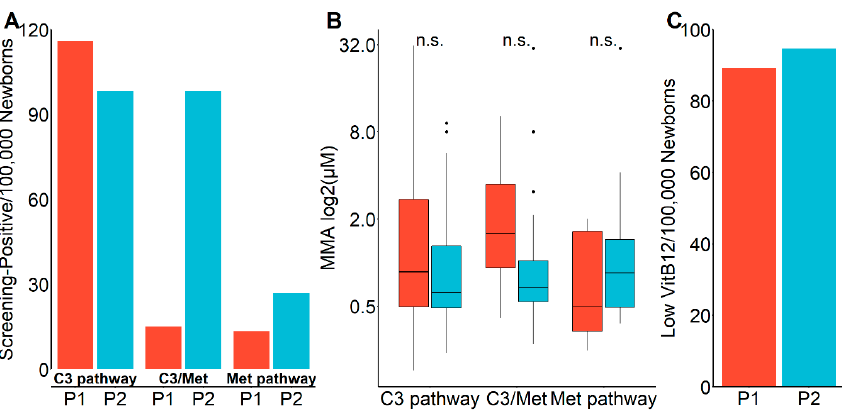
Figure 5. Impact of selection criteria on vitamin B12 (VitB12) screening performance. ( A ) Frequencies of screening-positives separated for the pathways via which samples have been selected for second-tier testing. Frequencies of samples selected via C3-dependent pathways (C3 high and C3 plus C3/C0, C3C2, or C3/C16), C3/Met, and methionine-dependent pathway (Met and Met/Phe), see Figure 1 for explanation, are depicted for indicated periods. ( B ) Methylmalonic acid (MMA) concentrations of samples selected via indicated pathways. Boxplots for MMA concentrations determined from dried blood spots of samples derived via indicated selection criteria and period. ( C ) Estimated frequency of low VitB12 in Austrian newborns. Frequency was estimated according to the number of screening- positives and proportion of low VitB12 concentrations within screening-positives. Red bars show values for the first screening period, blue bars for period 2; P1, first period; P2, second period of screening; n.s., non-significant.